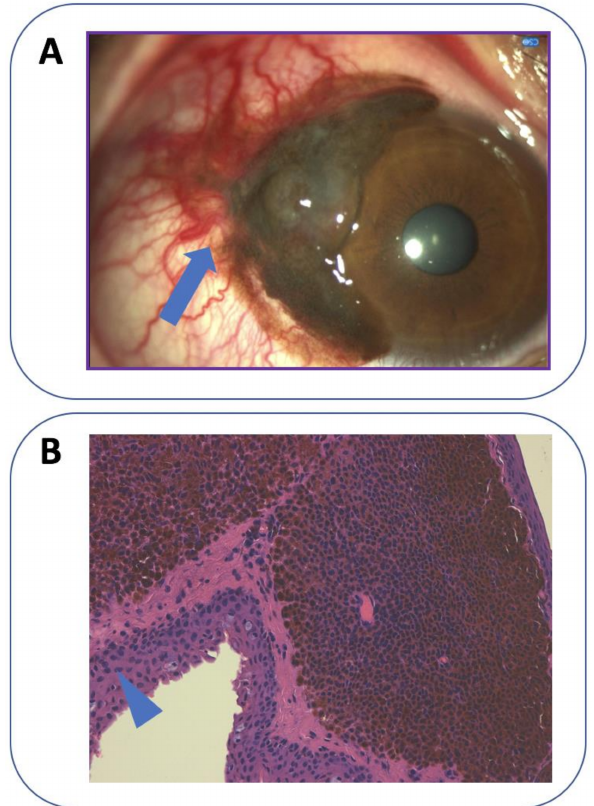
Figure 1. Clinical and histological appearance of melanoma of the bulbar conjunctiva. ( A ) A pigmented elevated, vascularized lesion (arrow) with feeder vessels located in the temporal bulbar conjunctiva and in the limbus. It originated in the conjunctival epithelium and gradually grew over the cornea. ( B ) Histological appearance of the lesion in (A). Dense cohesive sheets of rounded cells with varying pigmentation can be seen in the stroma, constituting a conjunctival melanoma. The overlying epithelium has normal appearance (arrowhead). Original magnification 200 × —courtesy of Vincenzo